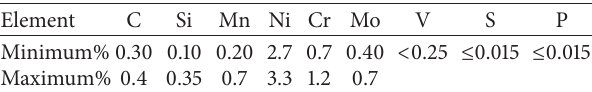
Table 1: Chemical composition of the J-Steel material.